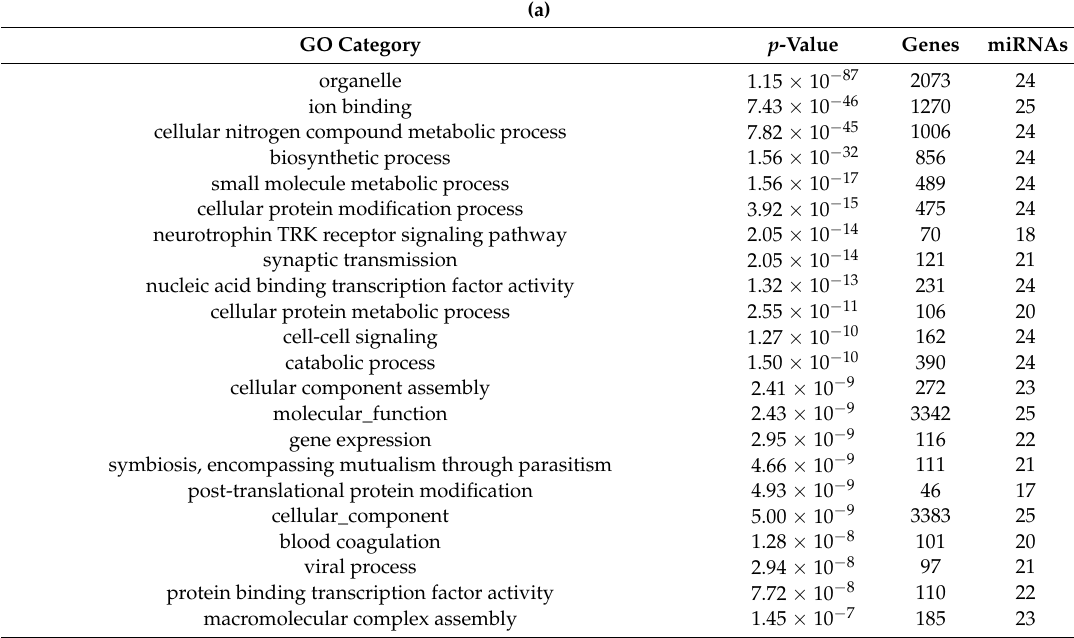
Table 3. Selected (firsts 50) gene ontology (GO) biological pathways potentially affected by ( a ) miRNAs down-regulated; and ( b ) miRNAs up-regulated in the presence of vitamin C in human bone marrow stromal